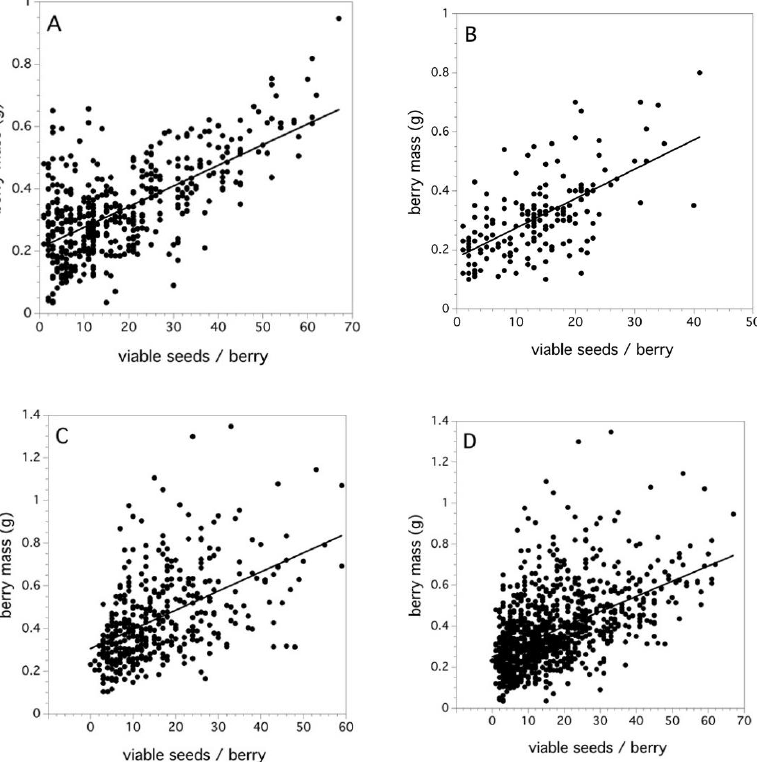
Figure 5. Relationships between viable seeds/berry and berry mass (g) for ( A ) 2006, ( B ) 2007, ( C ) 2011, and ( D ) all 3 years. Lines are least square regression lines.